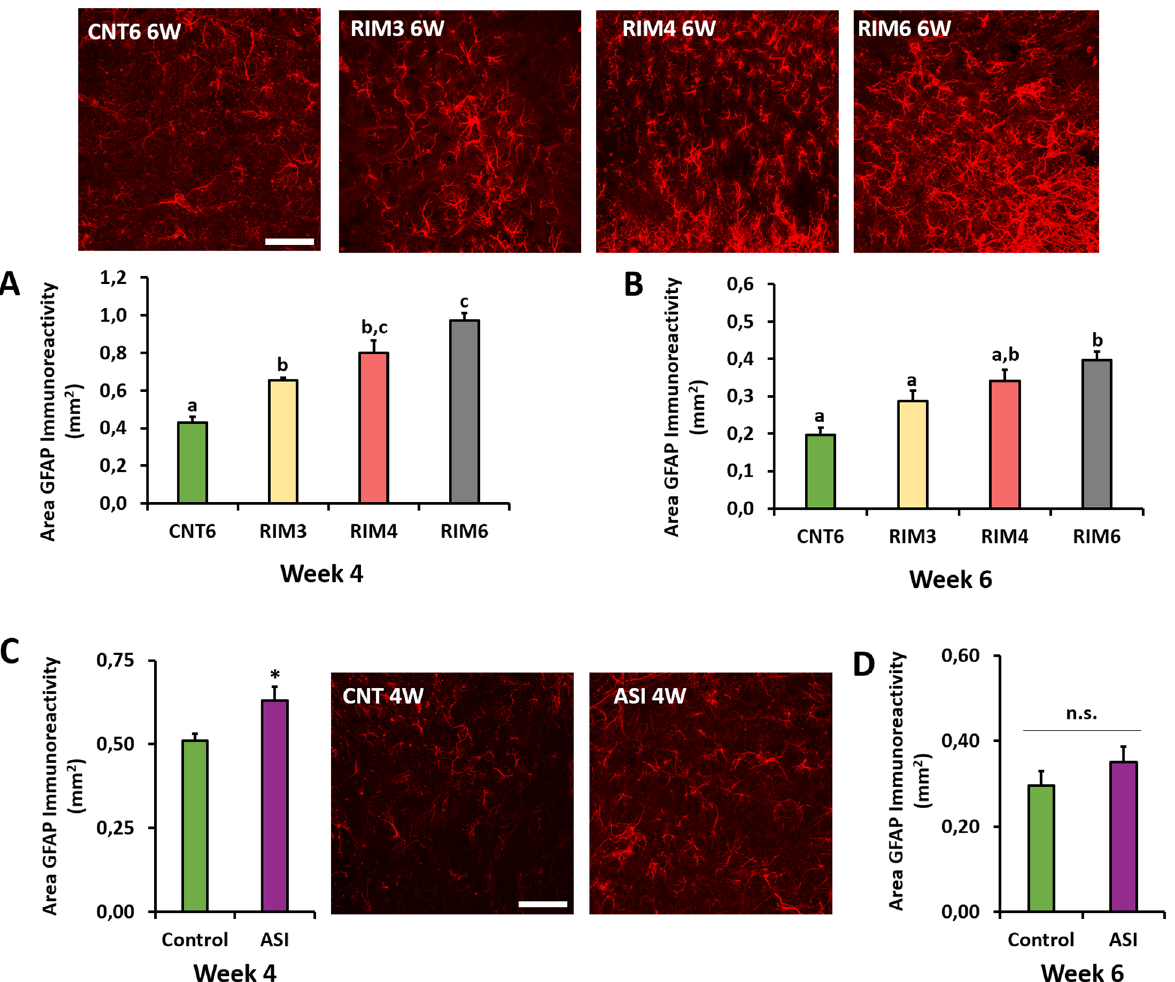
Figure 2. Spinal cord astrogliosis in mice subjected to reserpine-induced myalgia and intramuscular acid saline solution injection. Representative histological images of GFAP-positive cells are presented around the figure. Groups not sharing a letter showed significant differences, p < 0.05; * p < 0.05 significant decrease versus ASI- Control, by post hoc